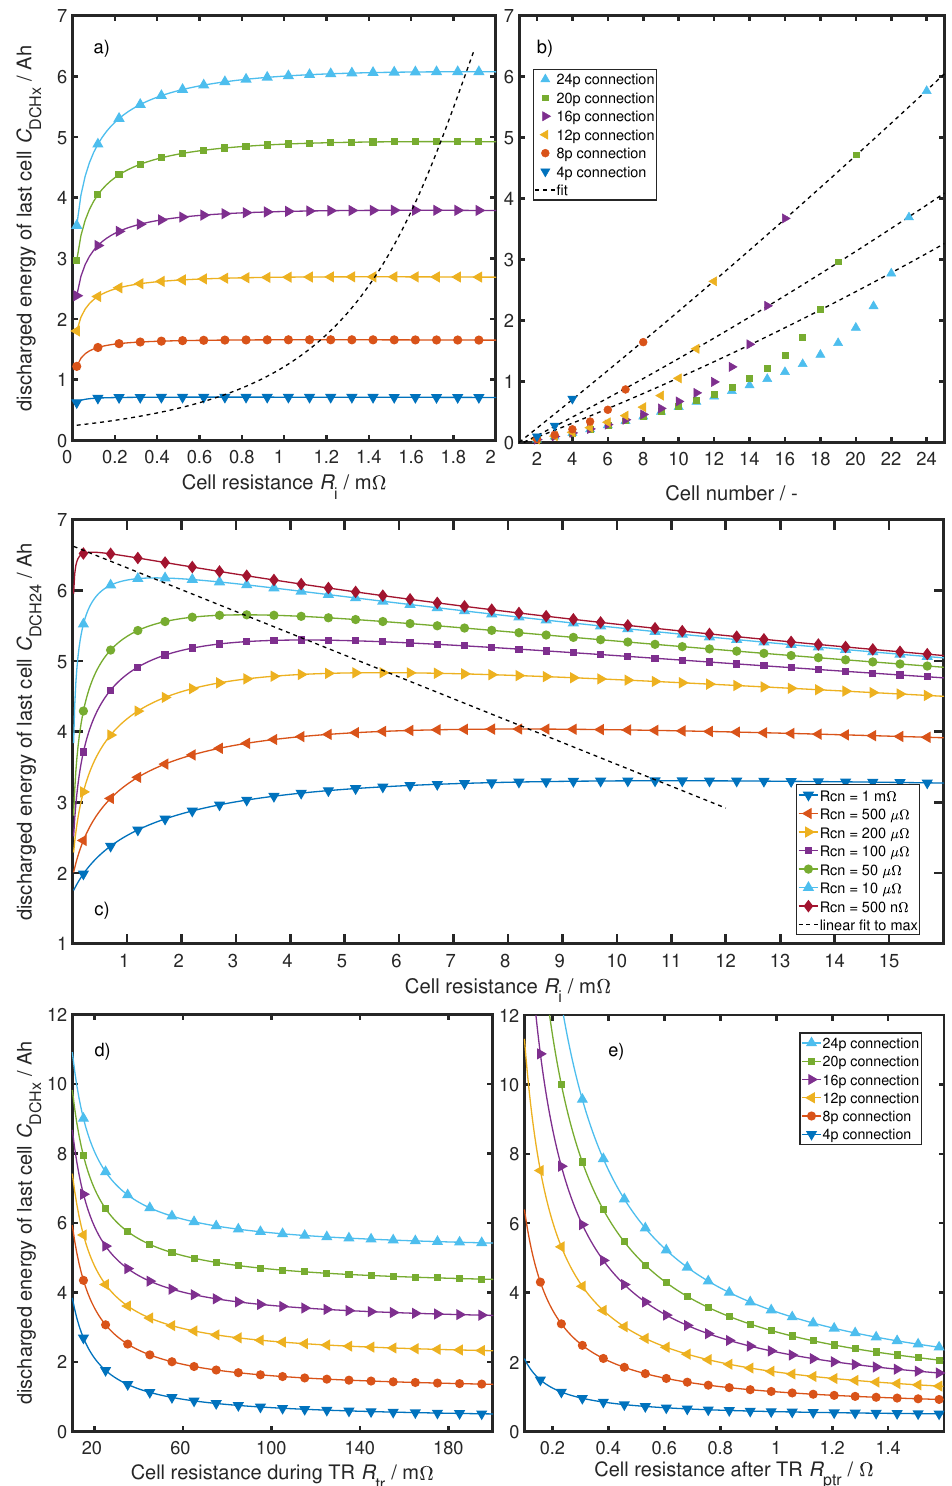
Figure 9. Influence analysis of the different system parameters. ( a ) different numbers of cells in parallel over cell internal resistance R i . The dashed line is a fit to the maxima; ( b ) total amount of discharged energy of each cell. The dashed line shows cubic correlation of the last cells to the number of parallel connected cells; ( c ) different connection resistances R cn over cell internal resistance R i . The dashed line is a linear fit to the maxima; ( d ) variation of cell resistance during TR R tr ; ( e ) variation of cell resistance after TR R ptr